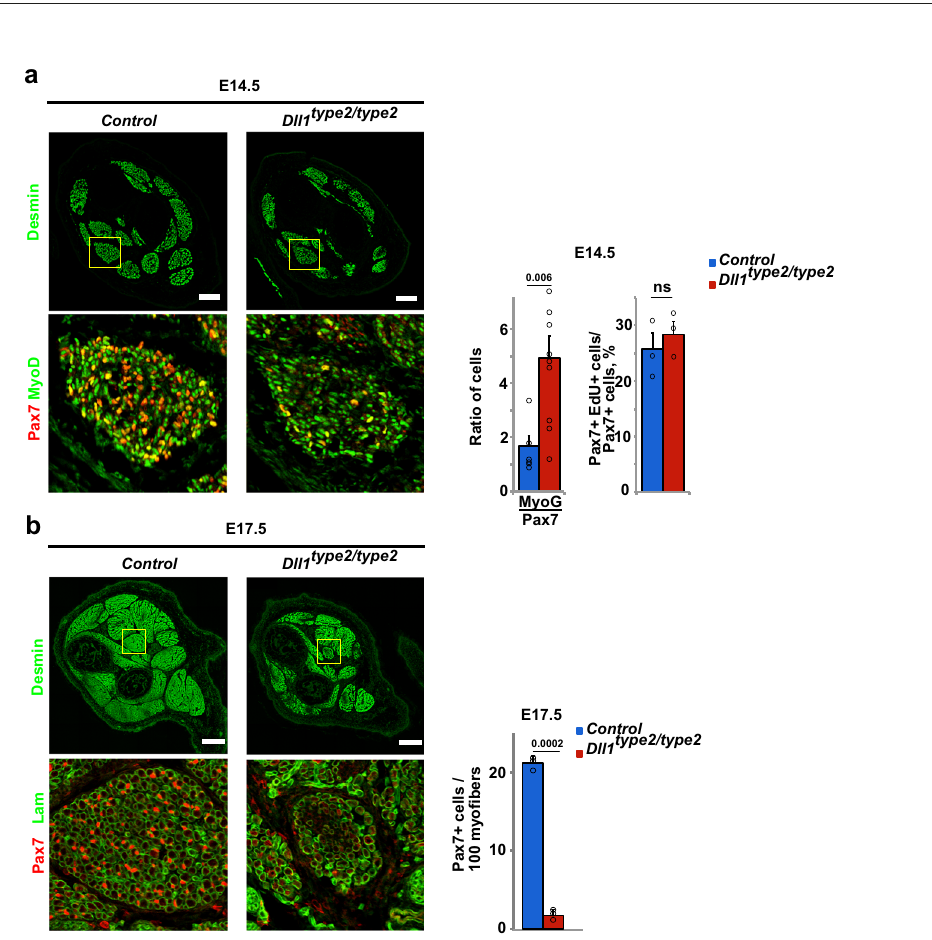
Fig. 8 Oscillatory Dll1 expression controls muscle growth in fetal development. a Immunohistological analysis of distal limb muscles of control and Dll1 type2/type2 mutant animals at E14.5 using the indicated antibodies. The ratio of MyoG + /Pax7 + cells and the quanti fi cation of the proliferation of Pax7 + cells (EdU incorporation into Pax7 + cells) is shown to the right ( n = 3 animals). b Immunohistological analysis of distal limb muscles of control and Dll1 type2/type2 mutant animals at E17.5 using the indicated antibodies. Quanti fi cation of the number of Pax7 + cells in the muscle is shown at the right ( n = 3 animals). Scale bars, 100 μ m ( a ) and 200 μ m ( b ). Data are presented as mean values± SEM. Exact p values are indicated, ns indicates P > 0.05, unpaired two-sided t Dll1 oscillations result in a temporally dynamic situation where myogenic cells send and receive Notch input. Mutations that change the Dll1 oscillatory dynamics but not the Dll1 expression level result in premature differentiation of myogenic cells and severely affect muscle development and repair. Thus, Dll1 pro- vided by a myogenic cell suppresses differentiation of neighboring myogenic cells, and Dll1 needs to oscillate to achieve the correct balance between self-renewal and differentiation (see summary in Fig. 9).